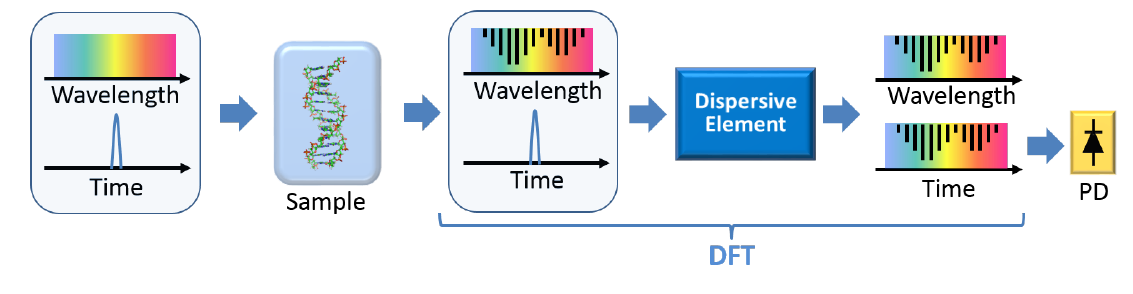
Figure 3. Schematic diagram to show the real-time spectroscopy based on DFT. PD: